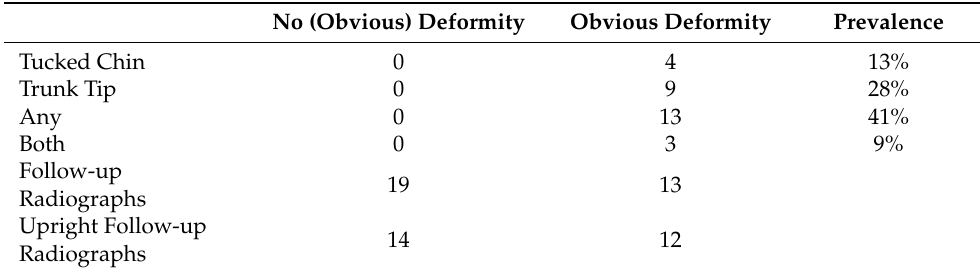
Table 2. Breakdown of cohorts studied and available radiographs.